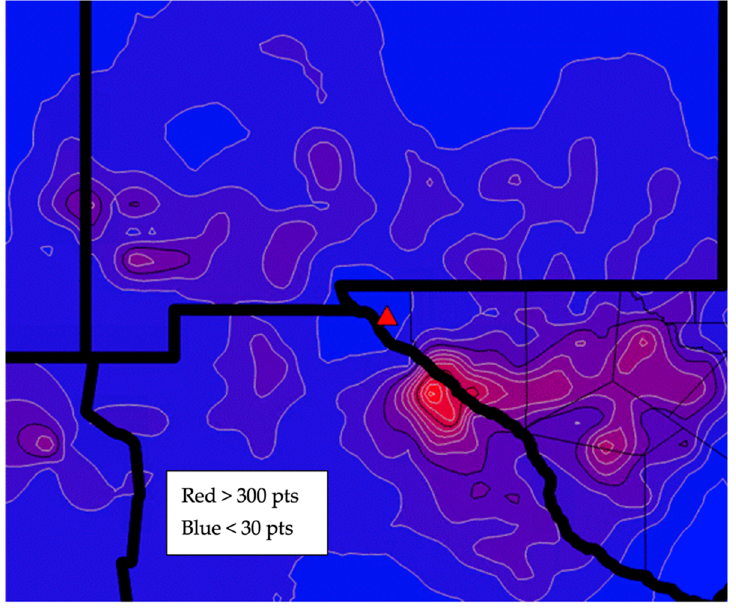
Figure 10. High ozone day back trajectory contouring points > 50 and < 200 miles from EPJA.